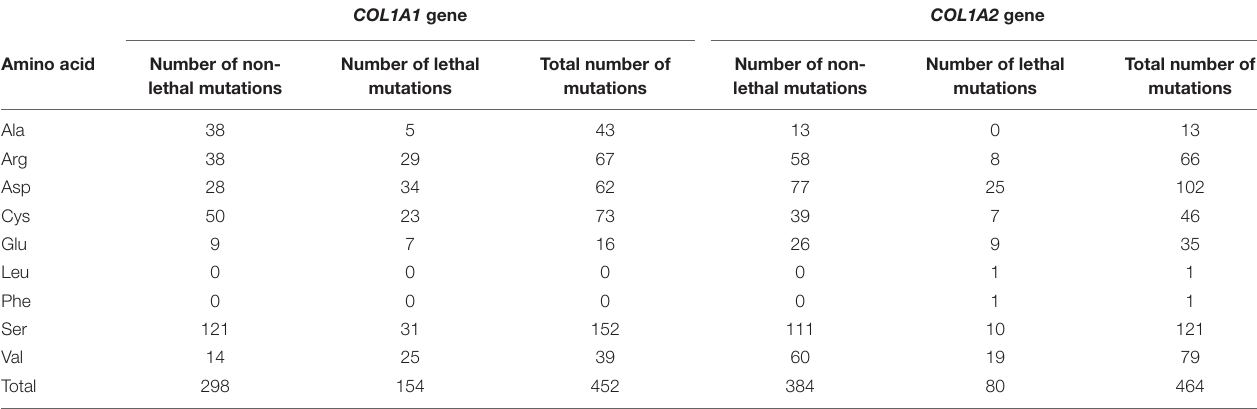
TABLE 4 | Summary of amino acids substituting for glycine in COL1A1 and COL1A2 gene resulting in a lethal